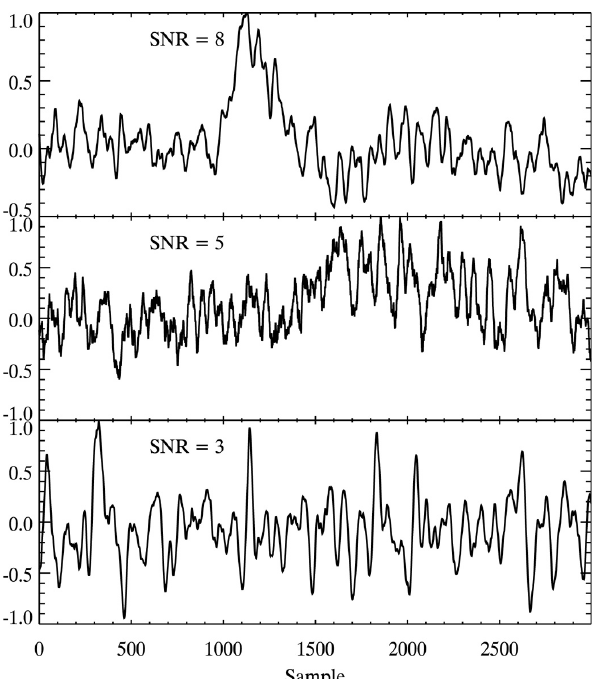
Fig. 15. Examples of normalized optical signals with varying SNR, showing that anything with SNR ∼ 5 is a reasonable threshold be- low which we regard the optical recording as a non-detection.